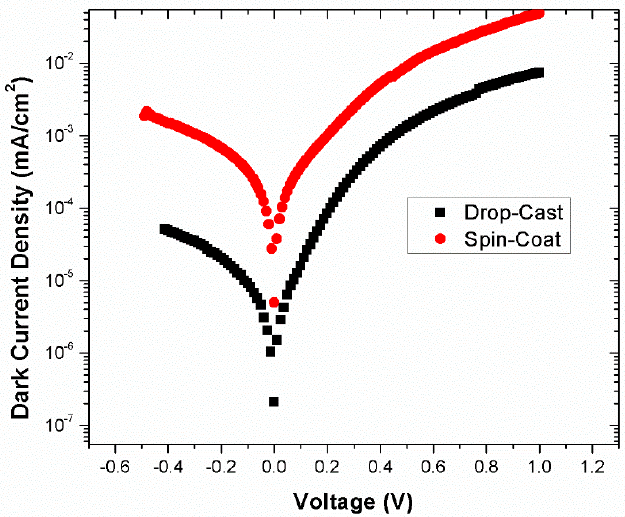
Figure 7. Dark J–V graph in log scale for drop-cast (four-layered) and spin-coated devices.